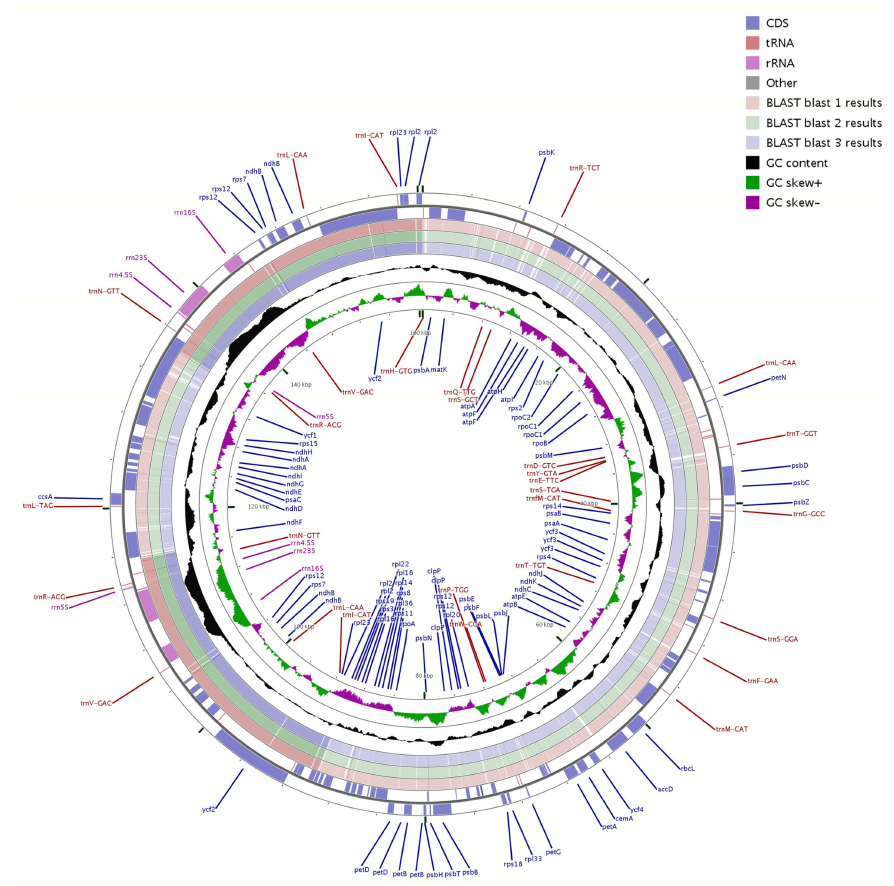
Figure 4. Comparison of four Quercus cp genome sequences. The outer four rings show the coding sequences, tRNA genes, rRNA genes, and other genes in the forward and reverse strands. The next three rings show the blast results between the cp genomes of Q. aquifolioides and three other Quercus species based on BlastN (blast 1–3 results: Q. aquifolioides Vs Q. aliena , Q. rubra , and Q. spinosa, respectively). The following black ring is the GC content curve for the Q. aquifolioides cp genome. The innermost ring is a GC skew curve for the Q. aquifolioides cp genome. GC skew+ (green) indicates G > C, GC skew − (purple) indicates G < C.